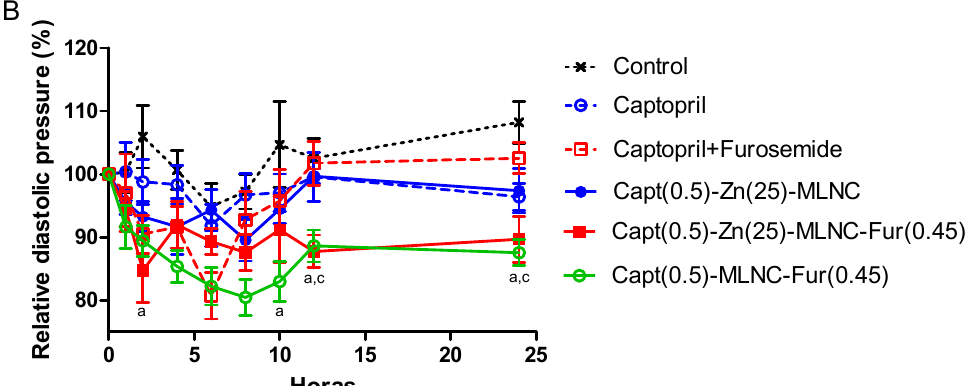
Figure 3. Systolic blood pressure ( A ) and diastolic blood pressure ( B ) (% from the basal pressure) from the fifth day of administration of solutions or formulations (8 mL kg − 1 ) by indirect tail method ( n = 6). Data are represented as means ± standard error of the mean. a Significantly di ff erent from control; b significantly di ff erent from captopril; c significantly di ff erent from captopril + furosemide; d